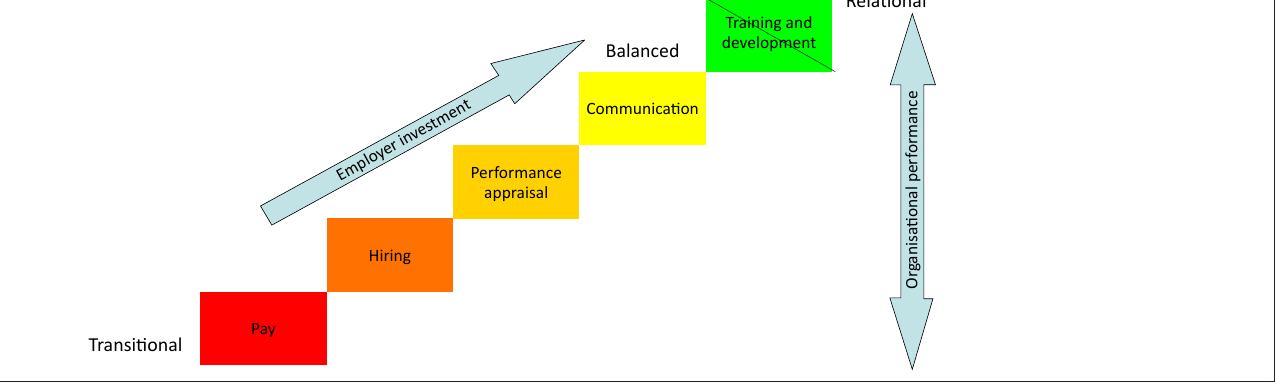
FIGURE 3: Model of the effect of human resource practices on psychological contracts.